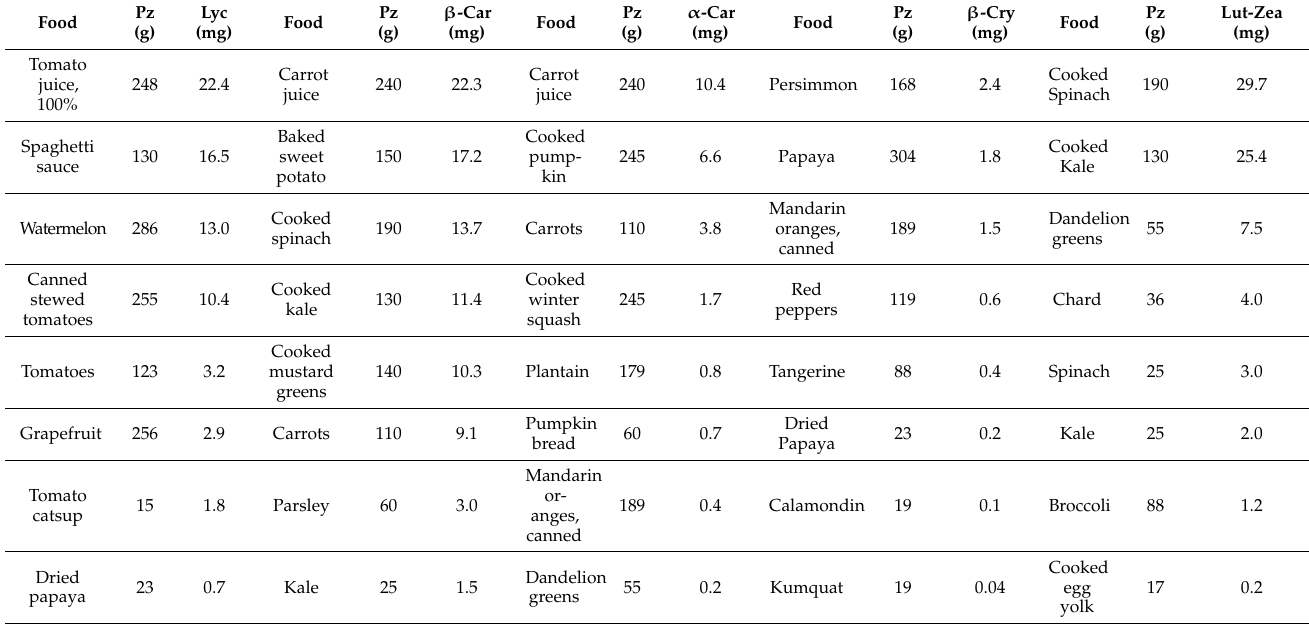
Table 1. Carotenoids content per portion (mg) (Adapted from [18]).